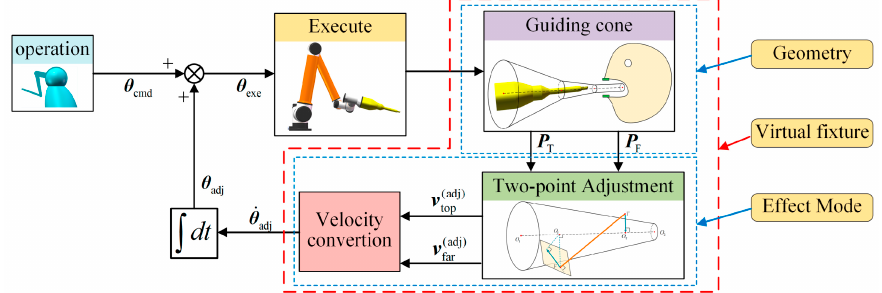
Figure 11. Adjustment effect and the complete virtual fixture framework.